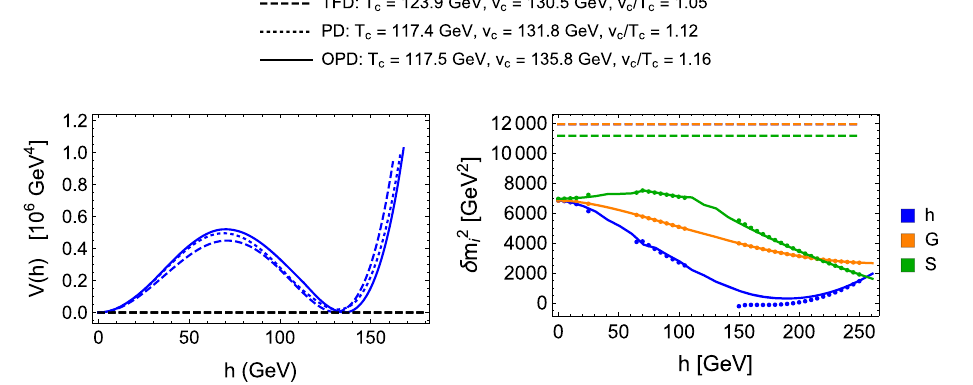
Fig. 3 Effective Higgs Potential (left) and mass corrections δ m 2 solutions as a function of h . This gives lating between the obtained δ m 2 i i nearly the same V ( h , T c ) as OPD. Note that the approximate equality (right) for the physical Higgs ( h ), Goldstones ( G ), and singlets ( S ) at T = T c asafunctionof h .EvaluatedinTFD,PDandOPDresummation of the three (O)PD mass corrections at the origin is a numerical coin- /v,λ loop ) = ( 300 GeV , 1 . 52 , 0 . 5 ) . cidence for this parameter point. Furthermore, the differences in v c , T c schemes for N S = 3 and ( m S ,λ loop hSS S between TFD and (O)PD are modest here, but for other choices they = δ m 2 Intherightplot, δ m 2 intheTFDscheme.Thedotscorrespondto h G can be much more pronounced. This is very important when T c ∼ T S δ m 2 in the PD scheme, with gaps indicating regions of the h -axis where i and the predicted nature of the transition can change from one-step to ( h , T ) no exact solution to the gap equation can be found, and the δ m 2 i two-step, as we discuss in Sect. functions used to evaluate the potential are obtained by linearly interpo-